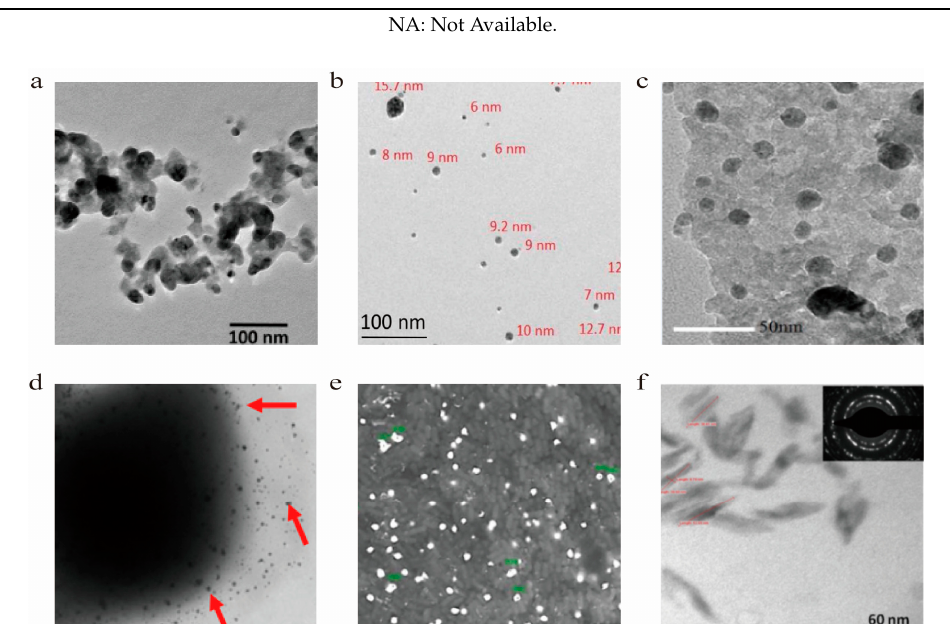
Figure 2. SEM and TEM images of biosynthesized elementary substance. ( a ) Ag-NPs by Bacillus sp. SBT8, scale bar: 100 nm (reprint from [39] with permission from Taylor & Francis. Copyright 2018); ( b ) Au-NPs by Acinetobacter sp. SW 30, scale bar: 100 nm (reprint from [42] with permission